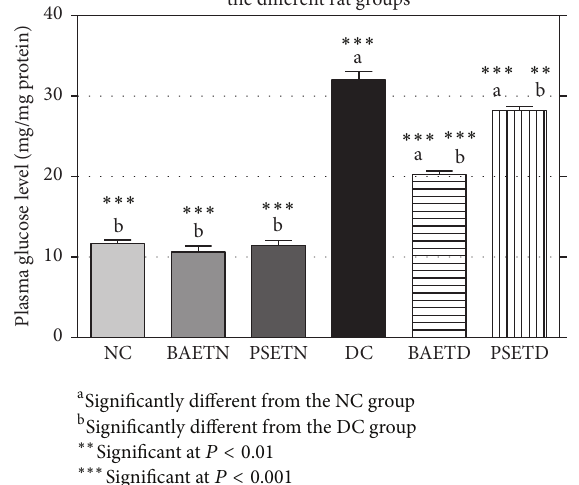
Figure 2: Balanites aegyptiaca fruits and Petroselinum sativum leaf aqueous extracts succeeded significantly ( 𝑃 < 0.001 ) in reducing the elevated mean plasma glucose level of the treated diabetic group in comparison with the DC